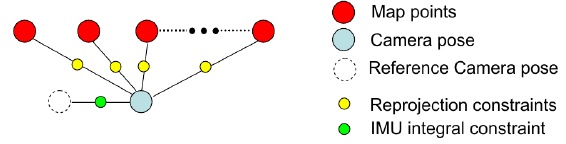
Figure 6. Factor graph for stereo IMU tightly-coupled